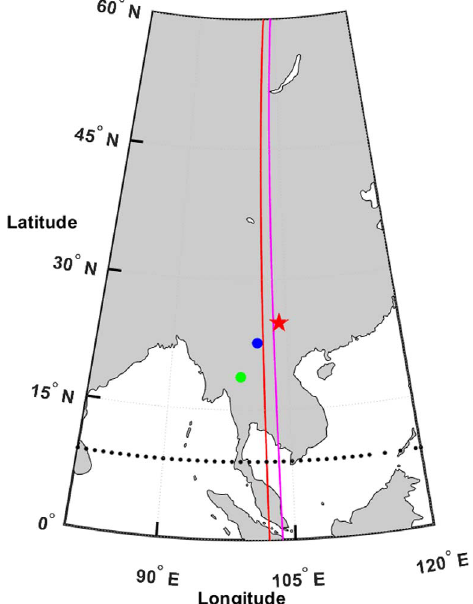
Fig. 1. Geophysical distribution of the pair of ionosondes (blue and green dots represent PUR and CMU, respectively), all-sky imager (red star), and the trace of the pair of Swarm A (the red solid line) and C (the magenta solid line) from ~13:03 UT to ~13:19 UT on 13 March 2015. The dotted backline represents the dip